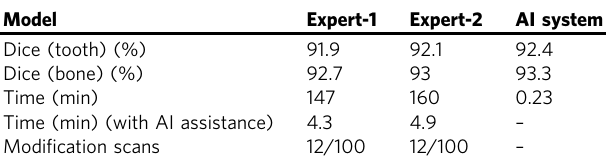
Table 3 Quantitative comparison between our AI system and two expert radiologists (tested on 100 CBCT scans randomly selected from external set).